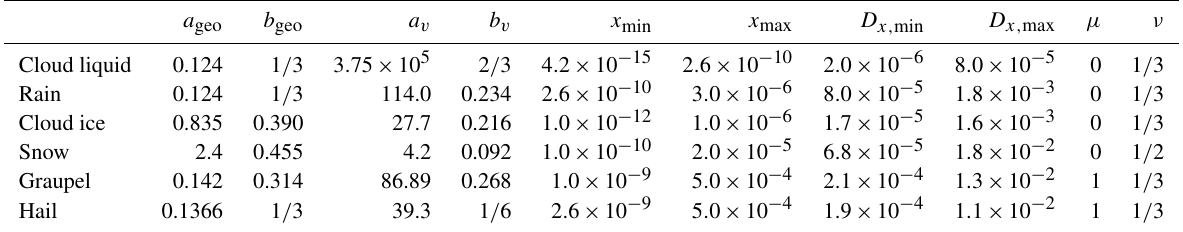
Table 1. Parameters of the size–mass and velocity–mass relationships, following Eqs. (2) and (3) used in the SB2M. These refer to D in units of meters, x in kilograms, and v T in meters per second. The last two columns contain the shape parameters of the assumed mass b g b g and D x, max = a g x distribution. D x, min = a g x max are the diameters corresponding to the mass limits x min and x max and are added for min better